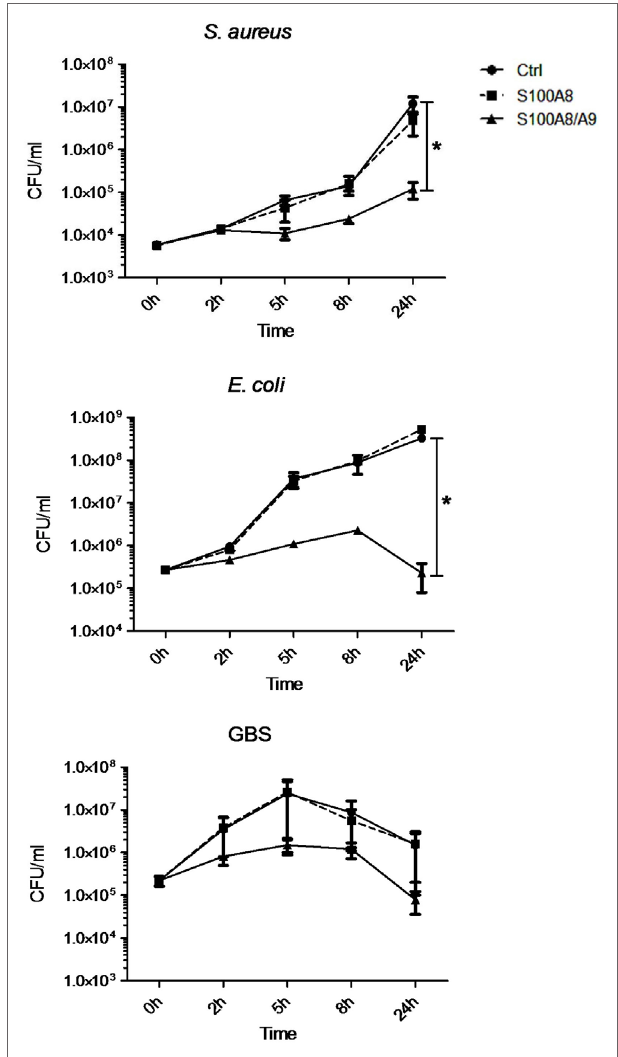
FigUre 2 | S100A8/A9 inhibits the growth of pathogens causing neonatal sepsis. Staphylococcus aureus , Escherichia coli , and group B streptococci (GBS) were grown in the absence [control (Ctrl)] and presence of 50 µg/mL S100A8/A9 or S100A8. The concentration of colony-forming units (CFU) over culture time was plotted as mean ± SEM. * p < 0.05, t -test ( n =